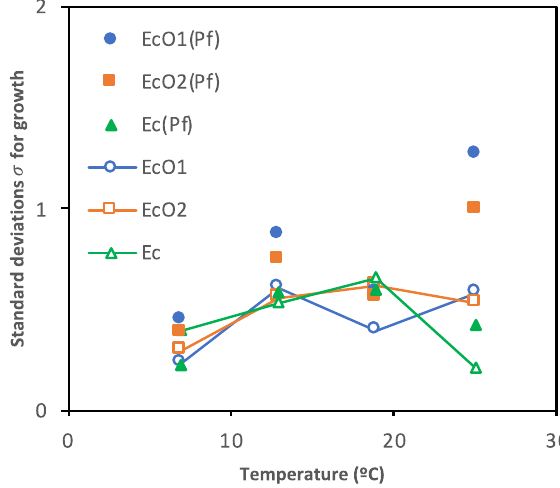
Figure 5. Scatter plot of the standard deviations for growth ( σ ) from E. coli spp. co-cultured with P. fluorescens (EcO1(Pf), EcO2(Pf), and Ec(Pf)) or single-cultured (EcO1, EcO2, and Ec) at 7, 13, 19 or 25 °C.